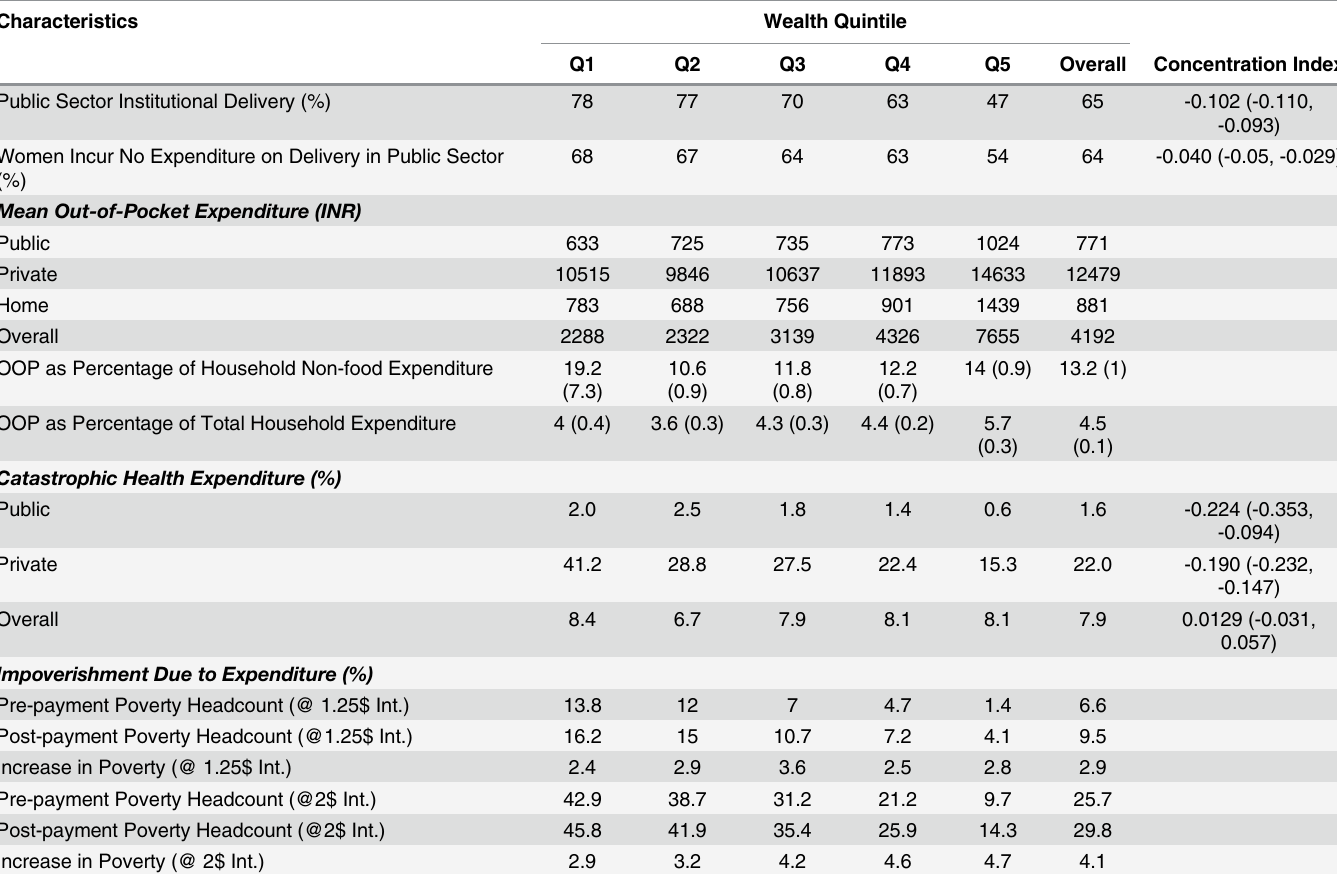
Table 2. Equity in Care Utilization and Out-of-Pocket Expenditure for Delivery in Haryana State, India.